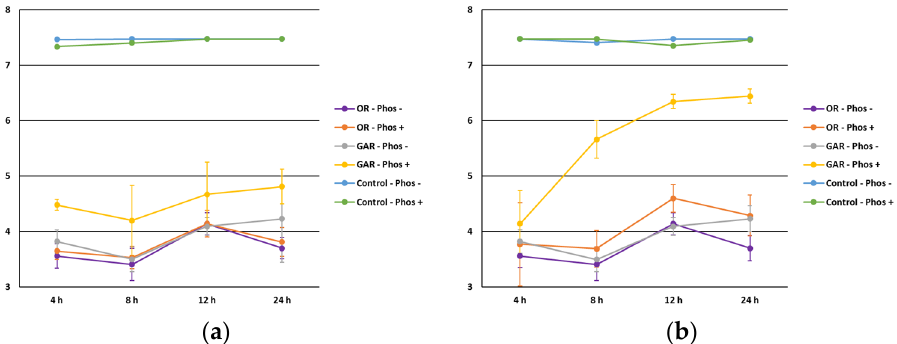
Figure 7. Influence of food phosphates’ (absence, Phos − ; presence, Phos+) level on the antimicrobial effect of oregano (OR) and garlic (GAR) essential oils against Salmonella spp. ( a ) and Listeria monocytogenes ( b ).